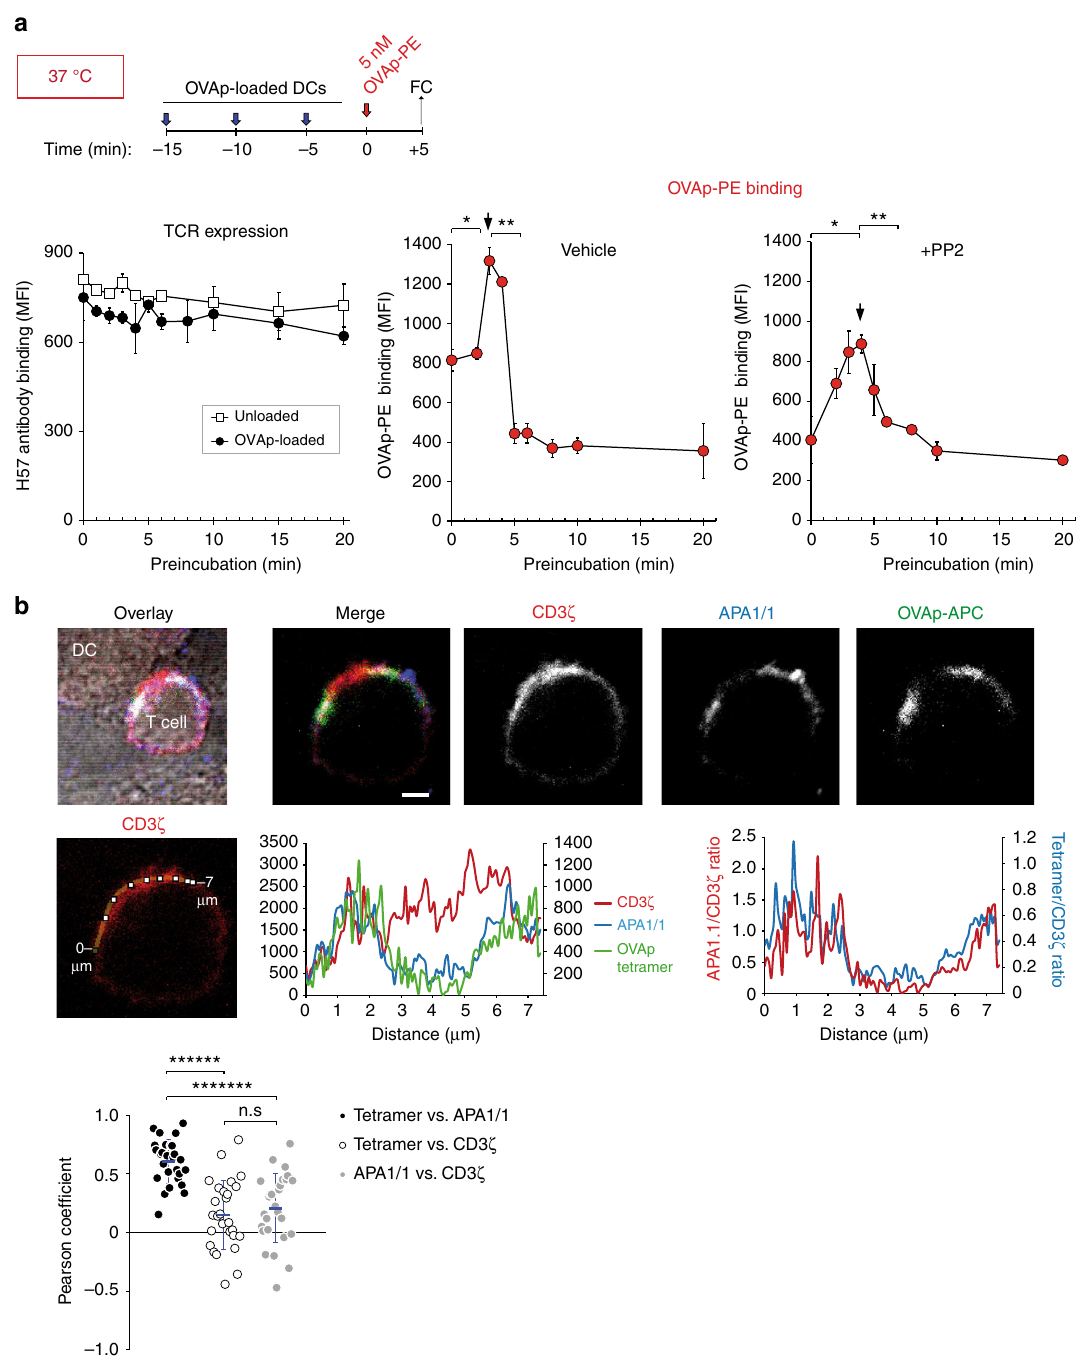
Fig. 7 The sites of enhanced tetramer binding co-localise with the Active TCR at the periphery of the immunological synapse. a CD8 + OT-1 T cells were treated with 20 µ M PP2 or vehicle for 30 min at 37 °C and then preincubated for the indicates times at 37 °C in the presence of mouse bone-marrow- derived dendritic cells (mDCs) loaded with OVA peptide. Subsequently, cells were incubated with 5 nM OVAp-PE for 5 min. Afterwards, cells were fi xed and stained with anti-CD8 and anti-H57 antibodies to quantify TCR expression. b CD8 + T cells from OT-1 CD3 ζ -GFP mice were puri fi ed by negative selection and incubated for 8 min at 37 °C in the presence of mDCs attached to a coverslip and pre-loaded with OVA peptide. Subsequently, cells were incubated with 20 nM OVAp-APC for 5 min. Before visualisation by confocal microscopy, cells were fi xed, permeabilized and stained with APA1-1 (top panel). Scale bar represents 1 μ m. Line scan drawn along the synaptic zone to show relative fl uorescence intensity of CD3 ζ , APA1-1 and OVAp-tetramer (middle left panel). Relative fl uorescence intensities of CD3 ζ , APA1-1 and OVAp-tetramer are represented versus distance (middle centre). Ratios between the relative fl uorescence intensity of APA1-1 and CD3 ζ or OVAp-tetramer and CD3 ζ are represented versus distance (middle right). Pearson correlation coef fi cients between the tetramer and APA1-1, the tetramer and CD3 ζ , or APA1-1 and CD3 ζ intensity distributions (bottom panel) are for n =